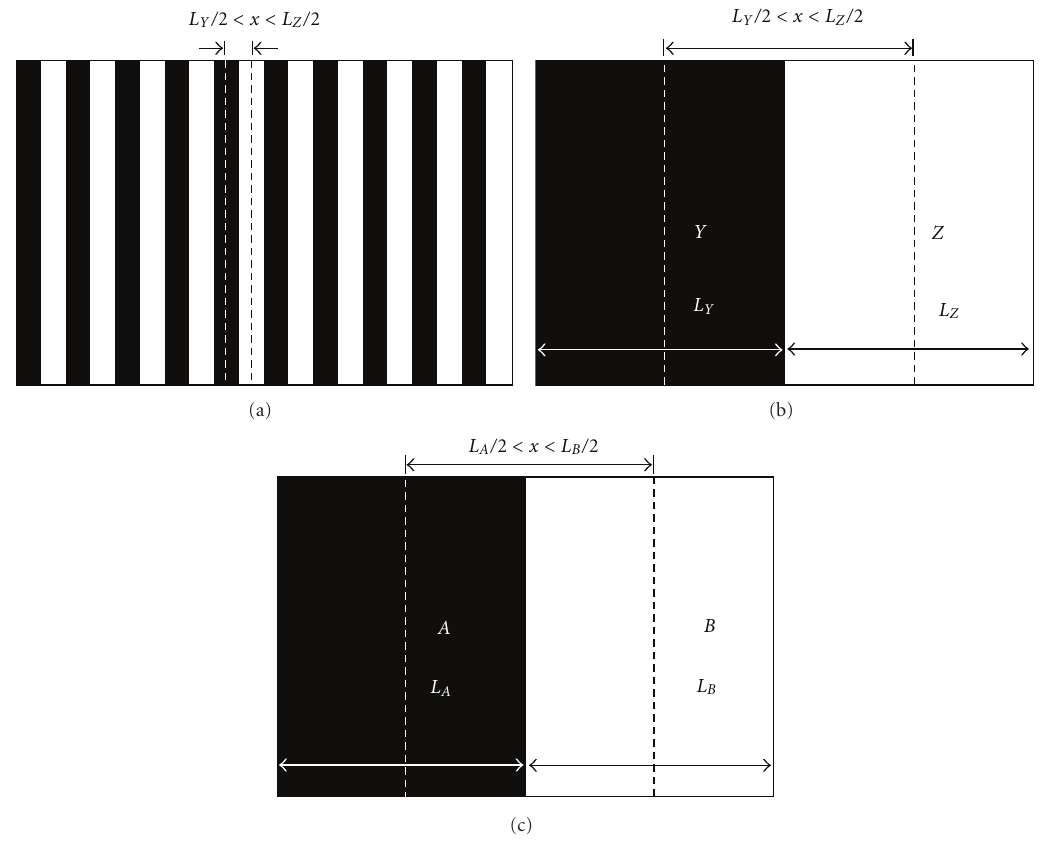
Figure 1: Geometry for proposed mixing model at time t = 0.